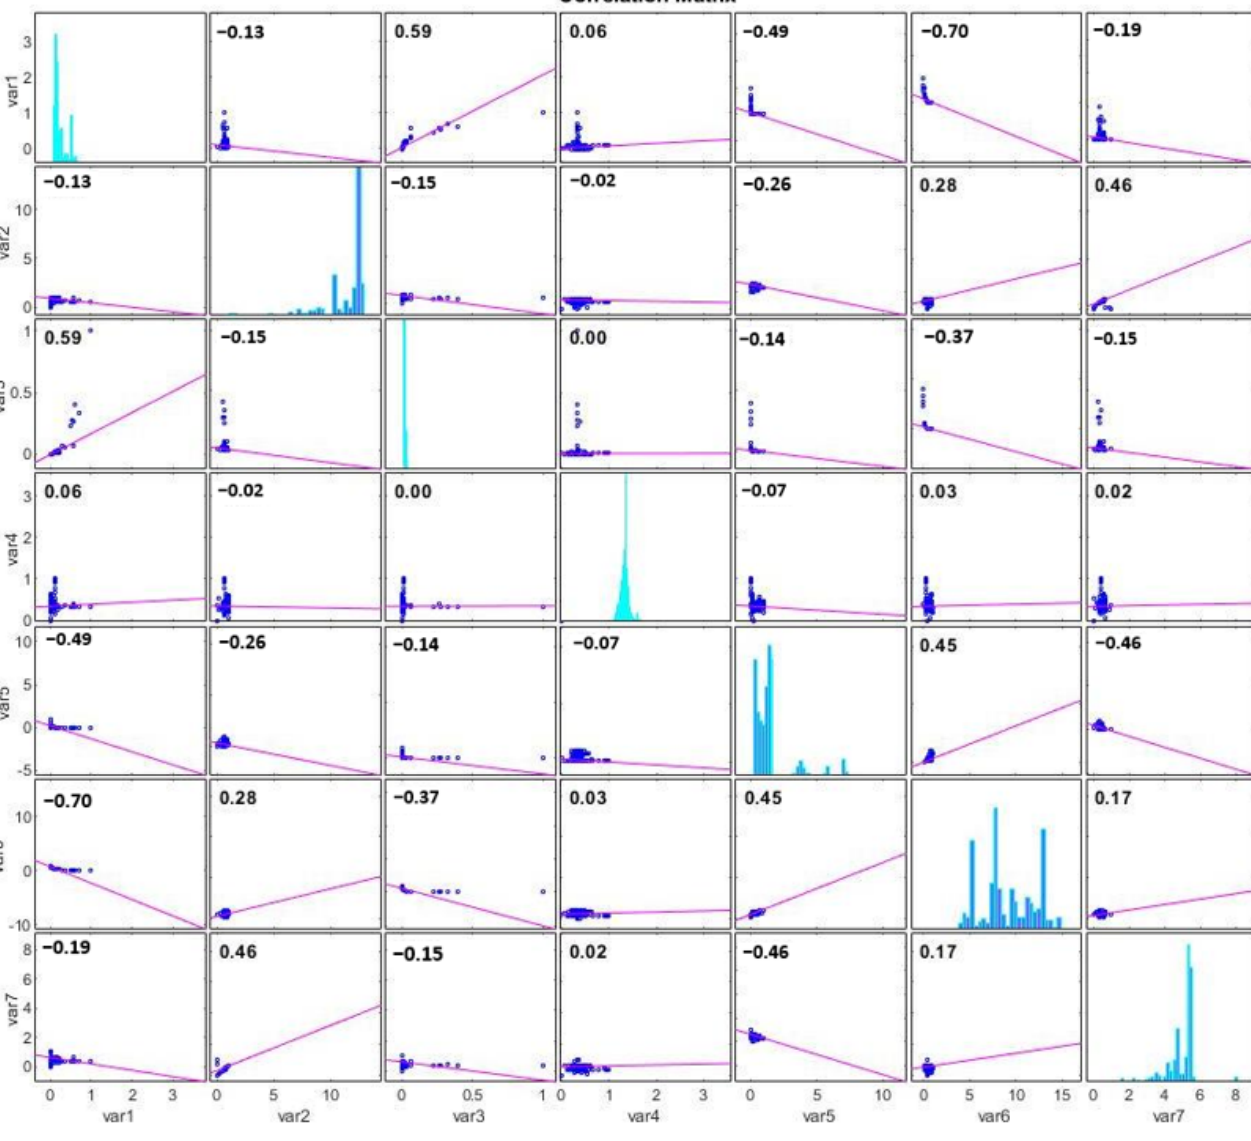
Figure 3. Correlation matrix of the final selected features (variables 1 to 7 as shown in the list